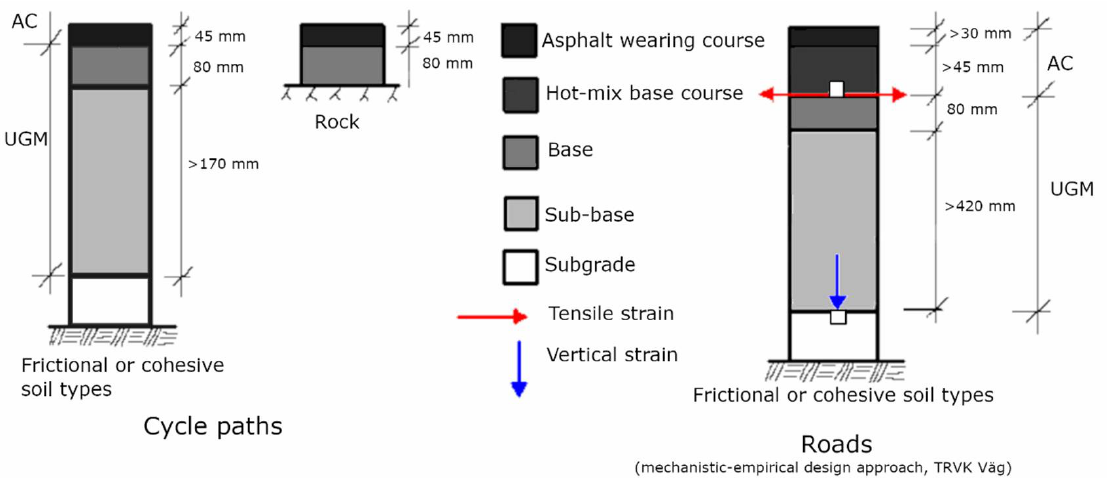
Figure 1. The structural design, with stipulated layer thicknesses of cycle paths and roads in the Swedish road- and street-design manual, TRVK Väg . The red arrows represent the design criteria of the tensile strain at the bottom of the AC layer, and the blue arrow represents the design criteria of the vertical strain on top of the subgrade.